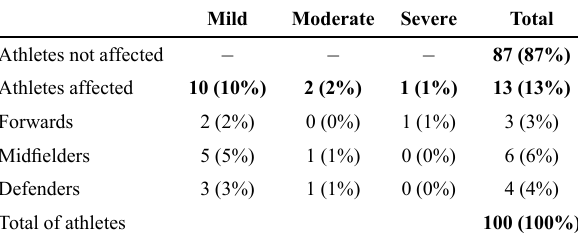
Table 3 - Prevalence of athletes affected by mild, moderate, and severe burnout. Mild Moderate